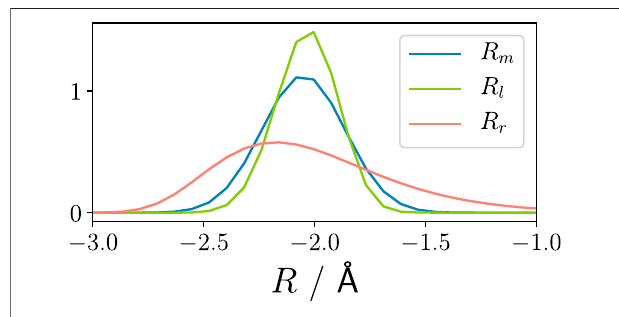
FIGURE 4 | Nuclear wave packet at the time of ionisation, t 0 , for R m ( t 0 ), R l ( t 0 ), R r ( t 0 ), see text.